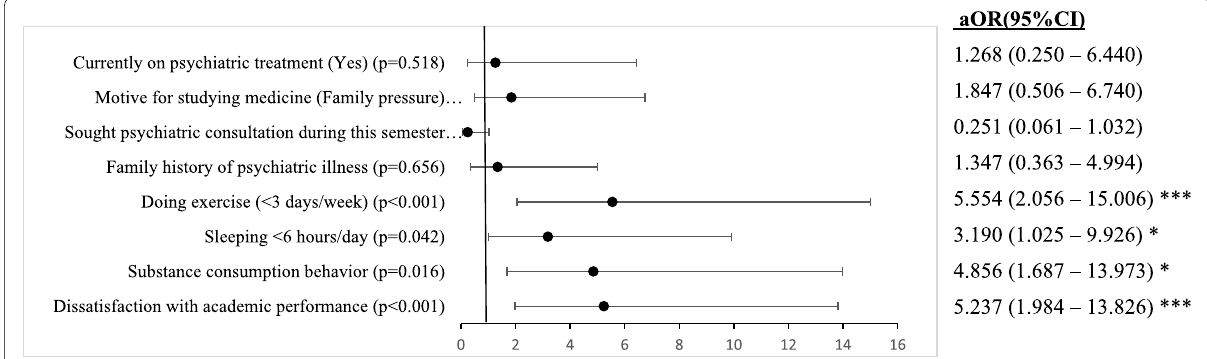
Fig. 2 Forest plot showing binary logistic regression analysis of psychological morbidities in clinical medical students. 95% CI, 95% confidence interval; aOR, adjusted odd ratio; odd ratio adjusted for current age, gender, residence (born/raised before entering the course), type of family, and living status during the course. * p < 0.05; ** p < 0.01; *** p <